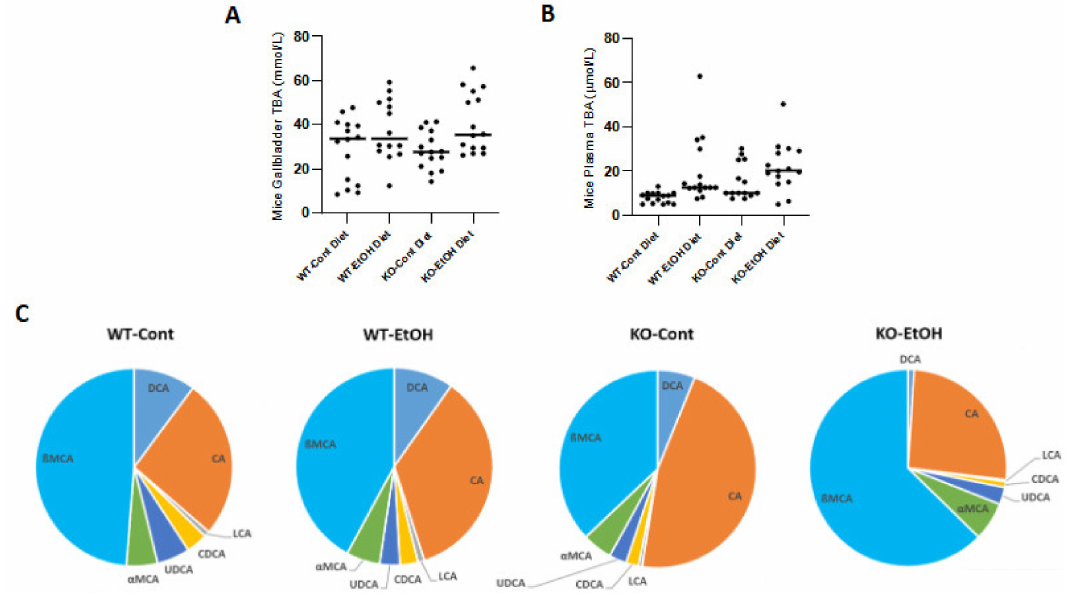
Figure 6. Total bile acid levels in male mouse gallbladder bile ( A ) and plasma ( B ) ( n = 14 per group). Plasma individual bile acids were identified by GC-MS-SIM ( n = 3 per group) and are shown as the percentage of total bile acid pool ( C ). Secondary bile acids comprise DCA, LCA, and UDCA. CA, cholic acid; CDCA, chenodeoxycholic acid; Cont, control diet; DCA, deoxycholic acid; EtOH, ethanol diet; KO, Abcb4 knockout mice; LCA, lithocholic acid; UDCA, ursodeoxycholic acid;